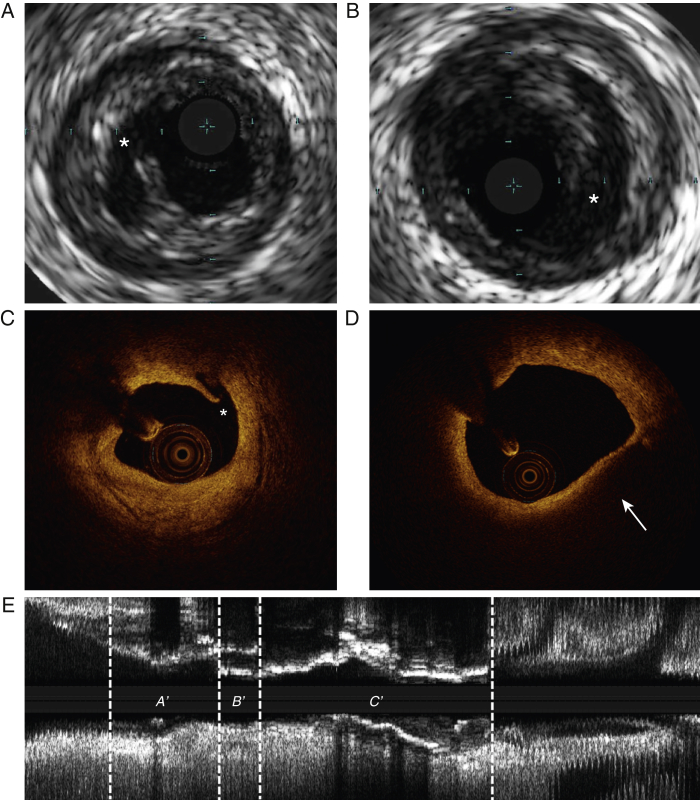
Identification of Plaque Rupture Using Gray-Scale Intravascular Ultrasound and Optical Coherence Tomography(A and B) Gray-scale IVUS images of spontaneous plaque rupture (*). (C) OCT image showing evidence of rupture (*).(D) Thin-cap fibroatheroma (arrow) as identified by OCT with no evidence of rupture or erosion. (E) Longitudinal IVUS reconstruction of a coronary artery with evidence of plaque rupture; proximal (A′); rupture site (B′); and distal (C′) segments. IVUS = intravascular ultrasound; other abbreviation as in Figure 1.